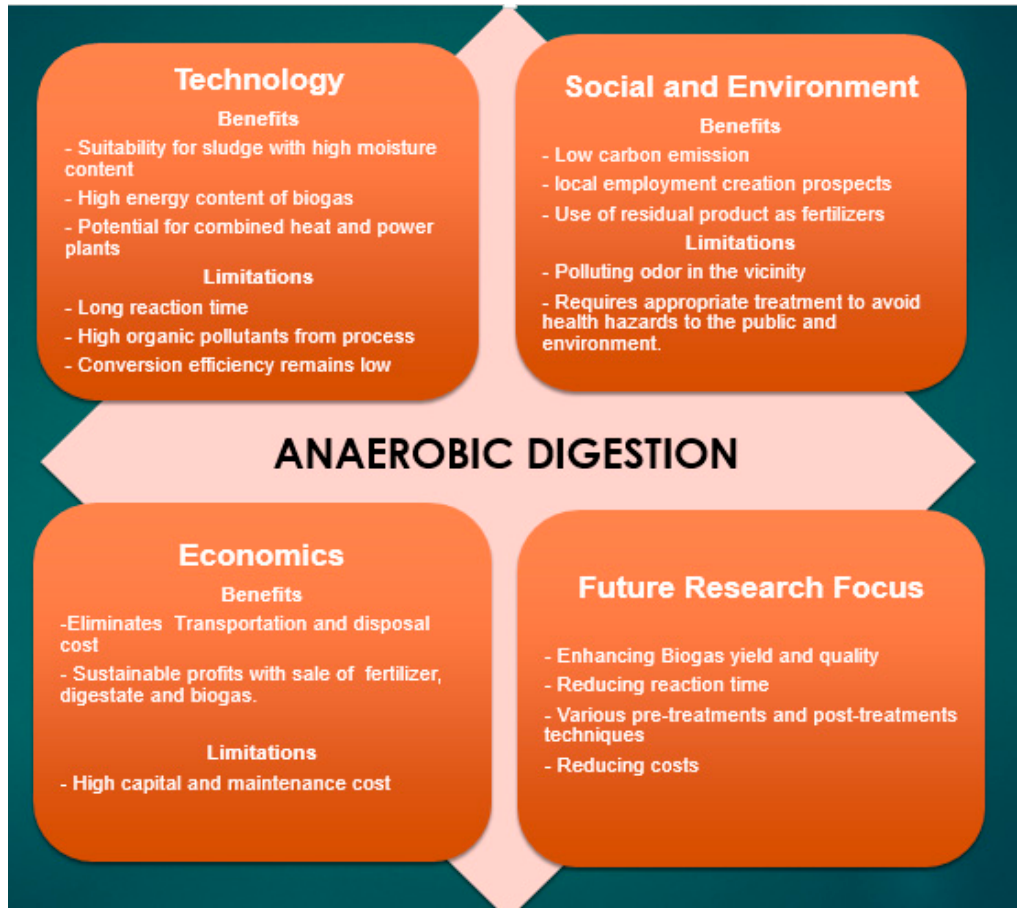
Figure 4. Technological, Socio-environmental and Economic Assessment of Anaerobic Digestion for Sludge Processing.